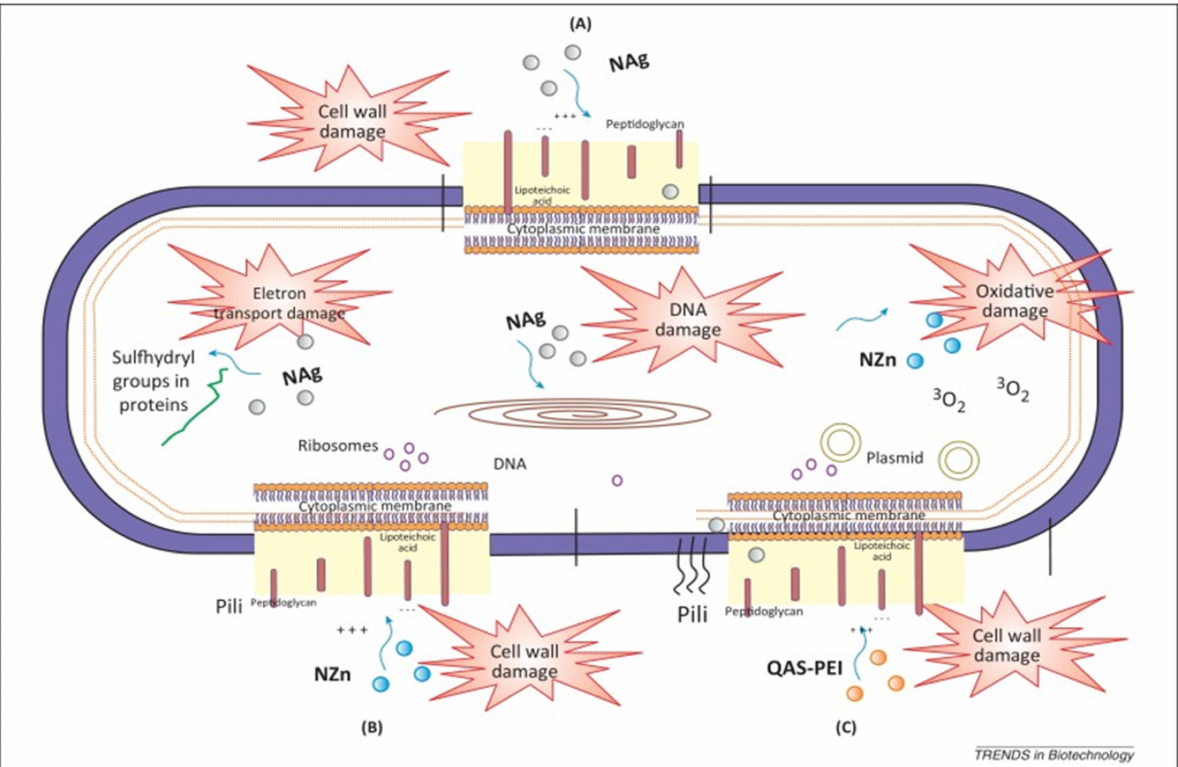
Figure 2. The possible antibacterial mechanisms of different antibacterial agents. ( A ): Schematic representation of antibac- terial mechanism of silver nanoparticles (Nag); ( B ): Schematic representation of antibacterial mechanism of zinc oxide nanoparticles (NZn); ( C ): Schematic representation of antibacterial mechanism of quaternary ammonium polyethylenimine (QAS-PEI). Adapted, with permission, from